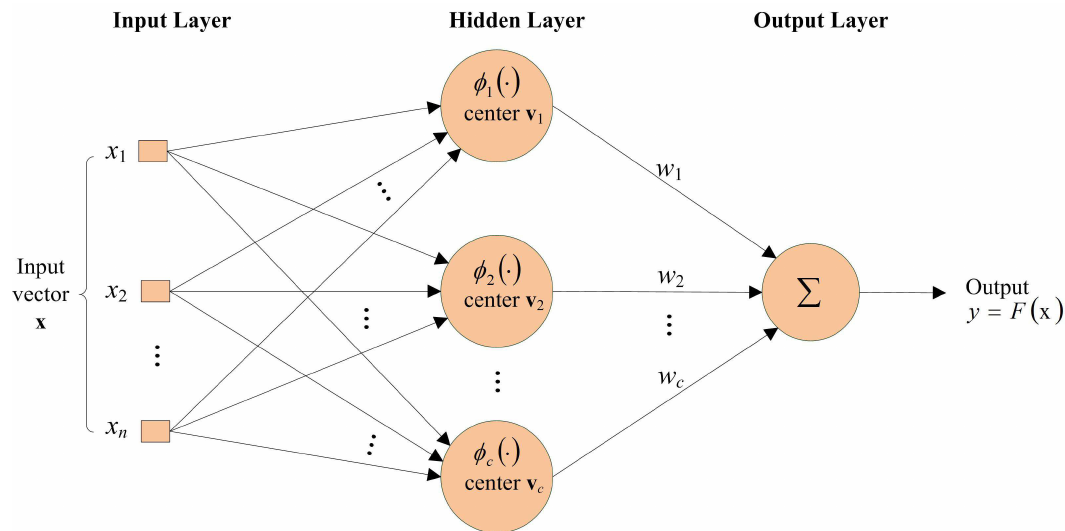
Figure 1. A typical RBF